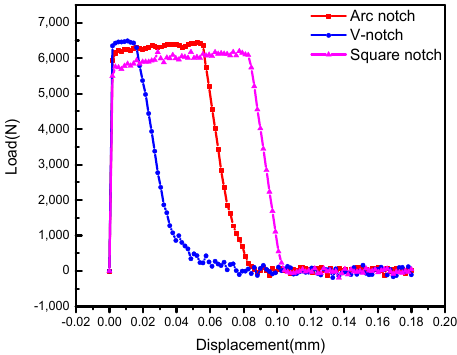
Figure 7. Effect of different notch structures on the shear load of a bolt.